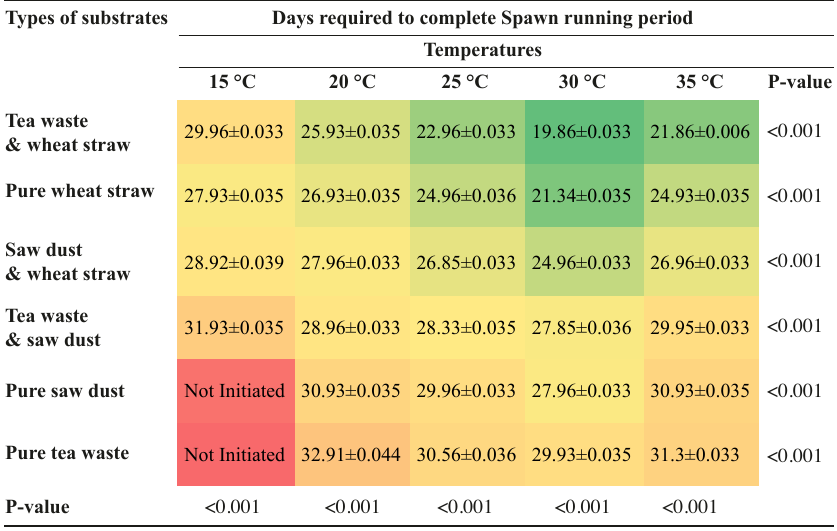
Tab. 3: Days required to complete Spawn Running Period on different substrates at variable temperatures Types of